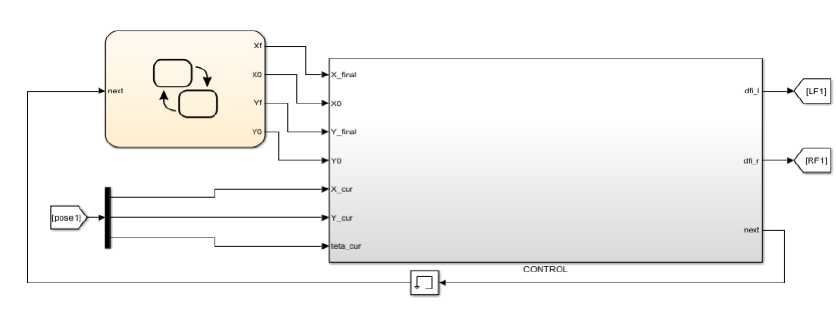
Fig. 3. Scheme for building a global trajectory via